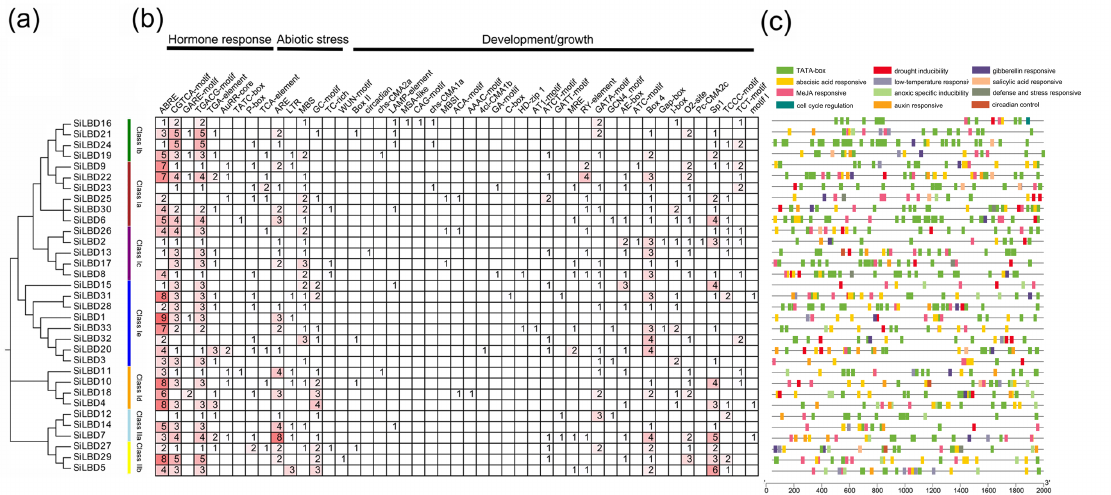
Figure 4. Identified cis-elements in putative SiLBD genes’ promoters. ( a ) Phylogenetic tree of 33 SiLBD genes. ( b ) Three types of cis-elements identified in the SiLBD genes’ promoters. The description on the top represents the predicted cis-elements in the promoter regions and tabulated numbers with different colors indicate the number of cis-elements. ( c ) Locations of 11 classes of cis-elements in SiLBD genes’ promoter